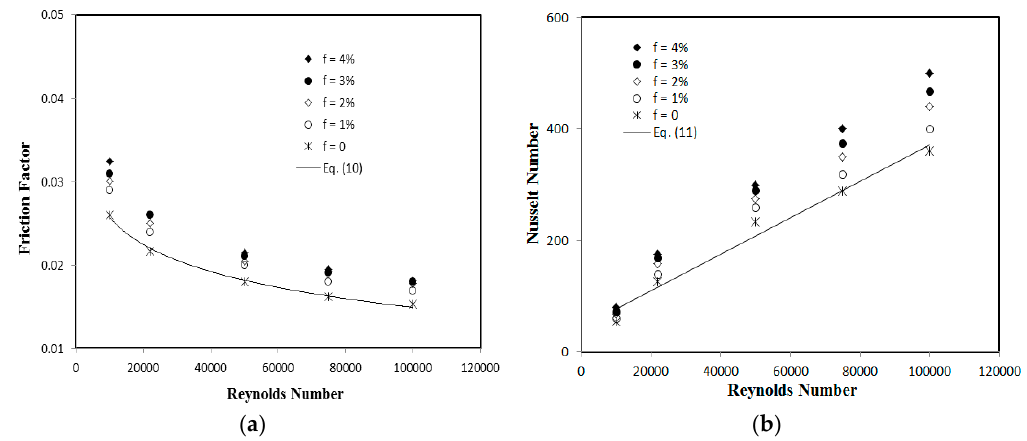
Figure 3. Effect of volume concentration. ( a ) Effect of volume concentration of nanofluid on fiction factor; ( b ) effect of nanofluid volume concentration on heat transfer enhancement.